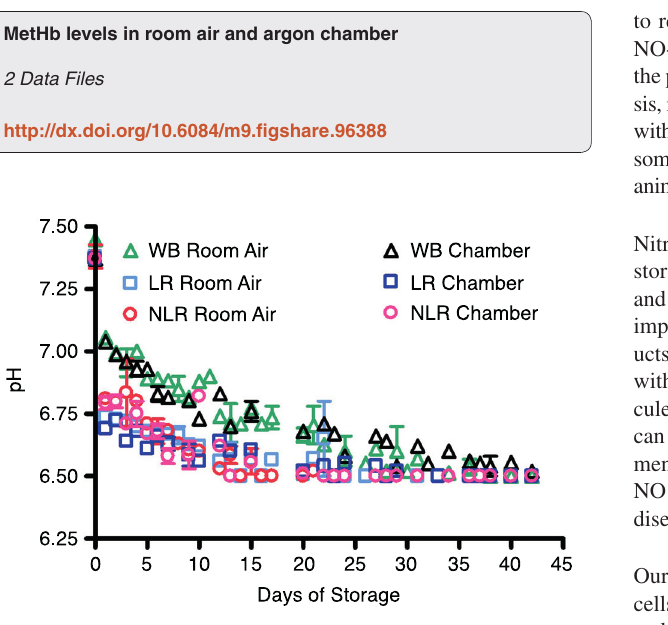
Figure 6. Change in MetHb levels in room air (6A) and chamber (6B) samples over 42 days of storage; number of donors, n=2 (A), n=2